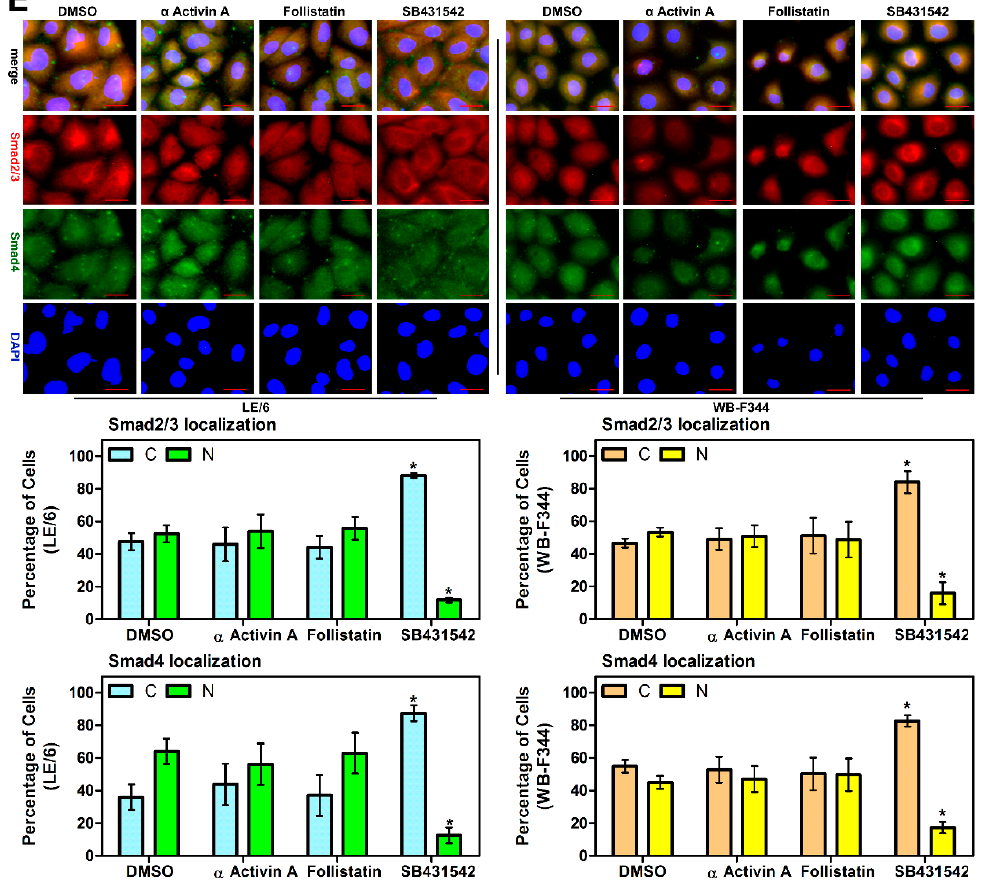
Figure 3. Intracrine Activin A signaling is activated in LPCs. ( A ) Cell lysates from LE/6 and WB-F344 cells were subjected to Western blot analyses with antibodies against Activin A. Glyceraldehyde-3-phosphate dehydrogenase (GAPDH) was used as a loading control; ( B ) Activin A secreted from WB-F344 and LE/6 cells was measured by enzyme-linked immunosorbent assay (ELISA). All results are means ± S.E.M. of triplicate measurements. Each experiment was repeated 3 times; ( C ) LE/6 and WB-F344 cells were treated with SB431542 at indicated concentrations. Cell lysates were subjected to Western blot analyses with antibodies against indicated proteins. β -Actin was used as loading control; ( D ) Upper panel : LE/6 or WB-F344 cells was co-transfected with pRL-TK and SBE4-luc plasmids and treated with indicated cytokines and inhibitors for 16 h. Luciferase activity was normalized to renilla luciferase activity and expressed as the means ± S.E.M. of triplicate measurements. Bars were compared as follows: * p < 0.01 compared with the first; ** p > 0.05 compared with the first and p < 0.05 compared with the second; *** p < 0.05 compared with the first and p < 0.01 compared with the second; Lower panel : LE/6 or WB-F344 cells was treated with indicated cytokines and inhibitors for indicated times. Lysates were subjected to Western blot analyses with antibodies against phospho-Smad2, phospho-Smad3 and Smad2/3. β -Actin was used as a loading control, arrow head indicated the band of p-Smad3; ( E ) LE/6 and WB-F344 cells were treated with indicated antibodies or inhibitors for 3 h and then subjected to double immunofluorescent staining of Smad2/3 (red) and Smad4 (green). DAPI were used to show the location of the nucleus (blue); scale bar, 20 μ m (Upper panel). Quantification of cells that showed Smad2/3 and Smad4 cytosolic (C) and nuclear (N) staining (Lower panel). * p < 0.05, compared with their control group (DMSO), respectively.